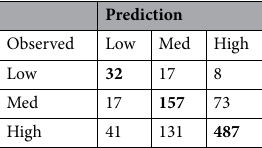
Table 2. RS-GBR-NMF-sparseLDA classification of CAPRA score (test